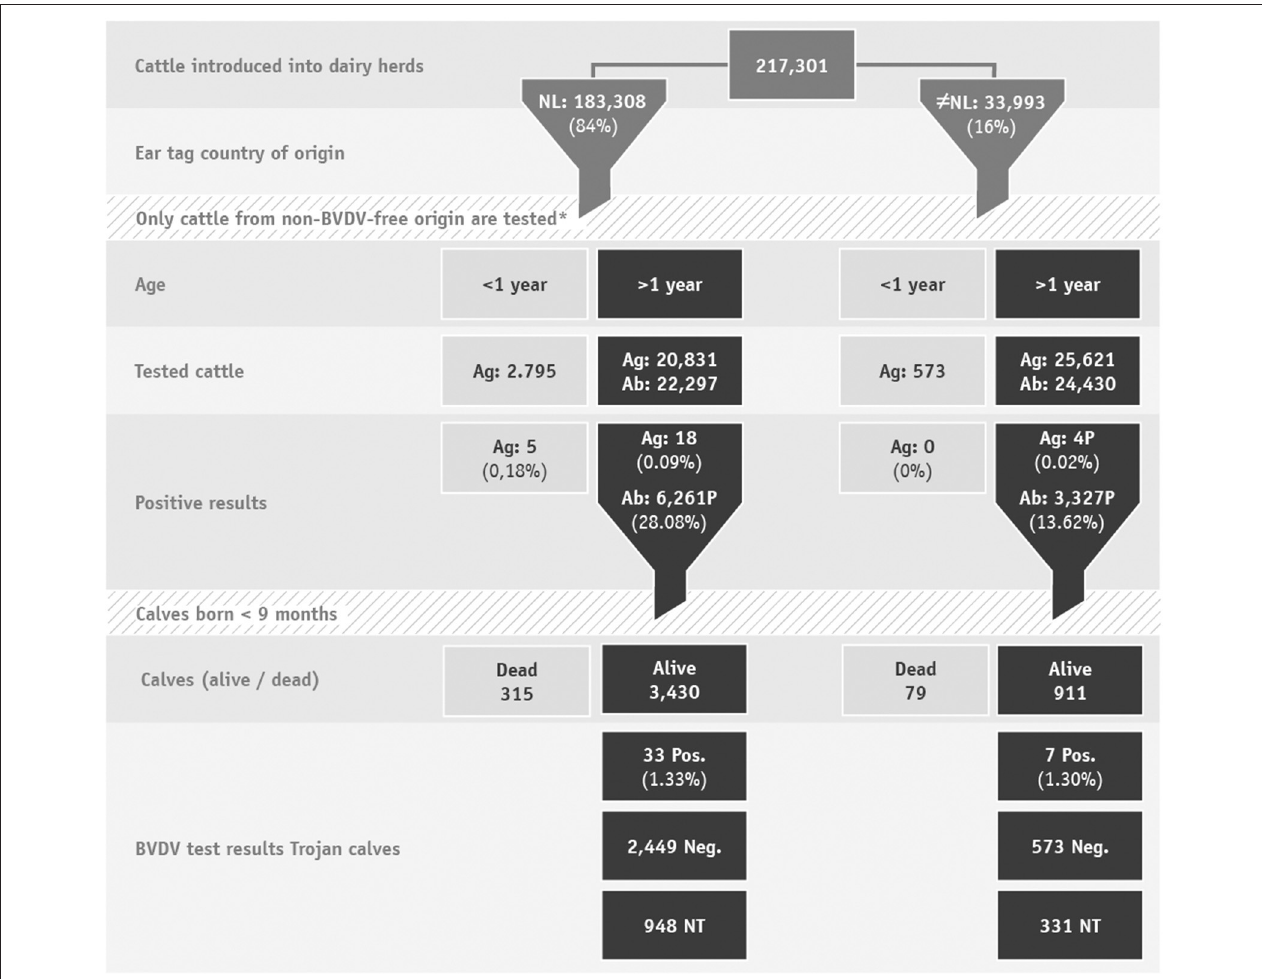
FIGURE 1 | Flowchart of cattle introduced into dairy herds and their test results. *Most introduced cattle originated from a BVDV-free herd, VE or a BVDV-free country, therefore testing is not required. Ag, antigen; Ab, antibody; NT, not